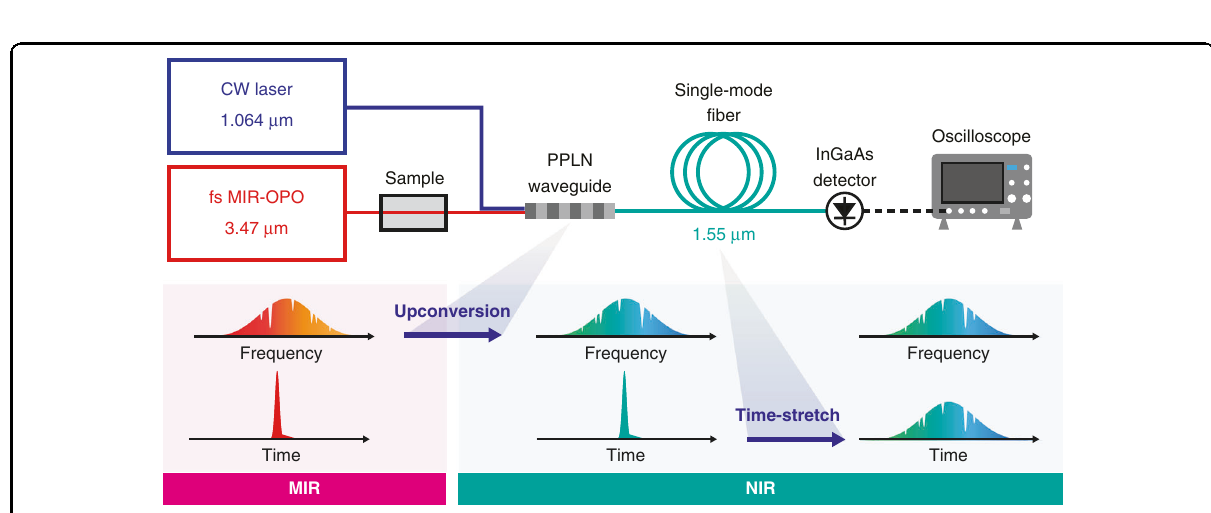
Fig. 2 Schematic of upconversion TSIR (UC-TSIR). MIR-OPO mid-infrared optical parametric oscillator, PPLN periodically poled lithium niobate